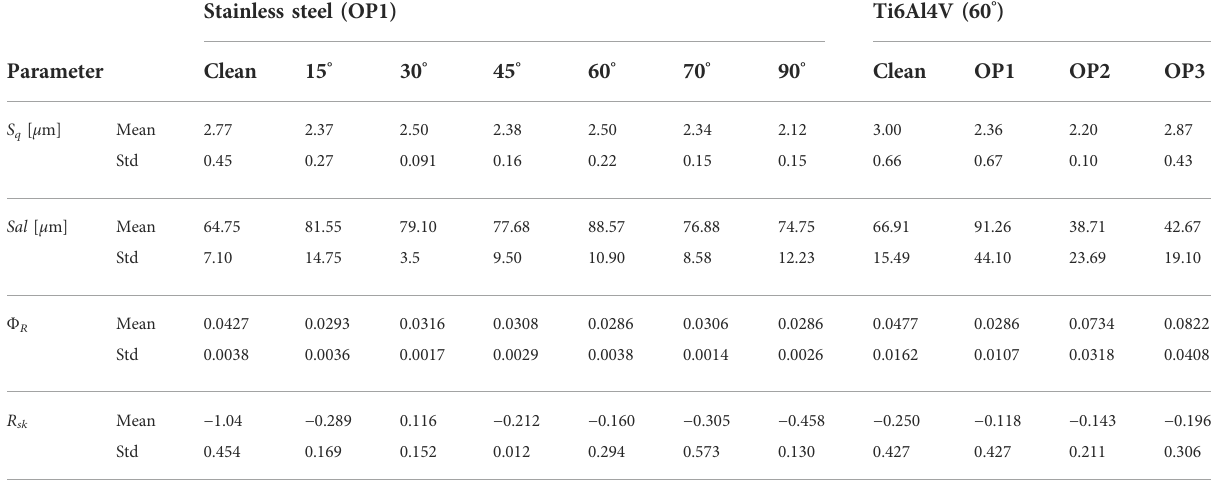
TABLE 1 Overview of surface roughness parameters of stainless steel target plates eroded at OP1 with different incidence angles and Ti6Al4V target plates for different impact velocities at 60 ° incidence angle. Stainless steel